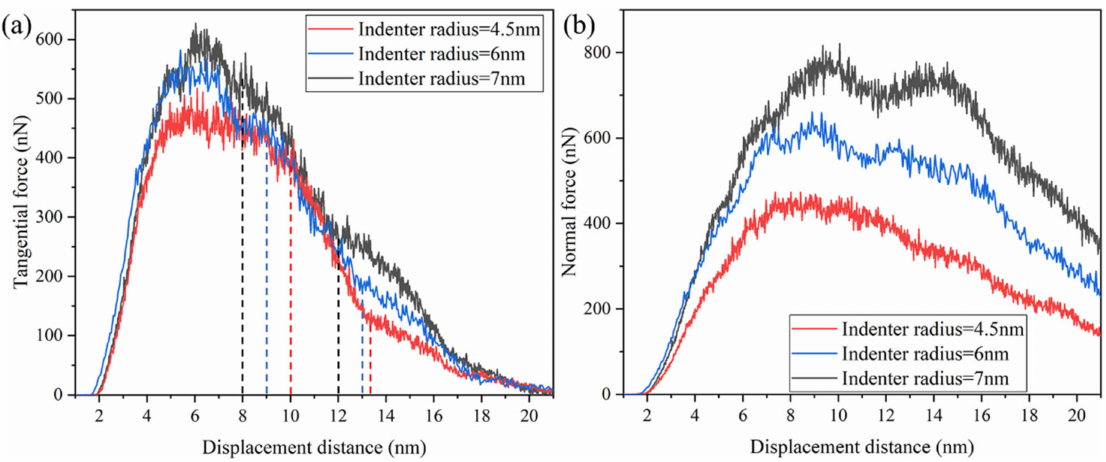
Figure 14. Variation of ( a ) the tangential forces and ( b ) the normal forces in various indenter radii against plowing